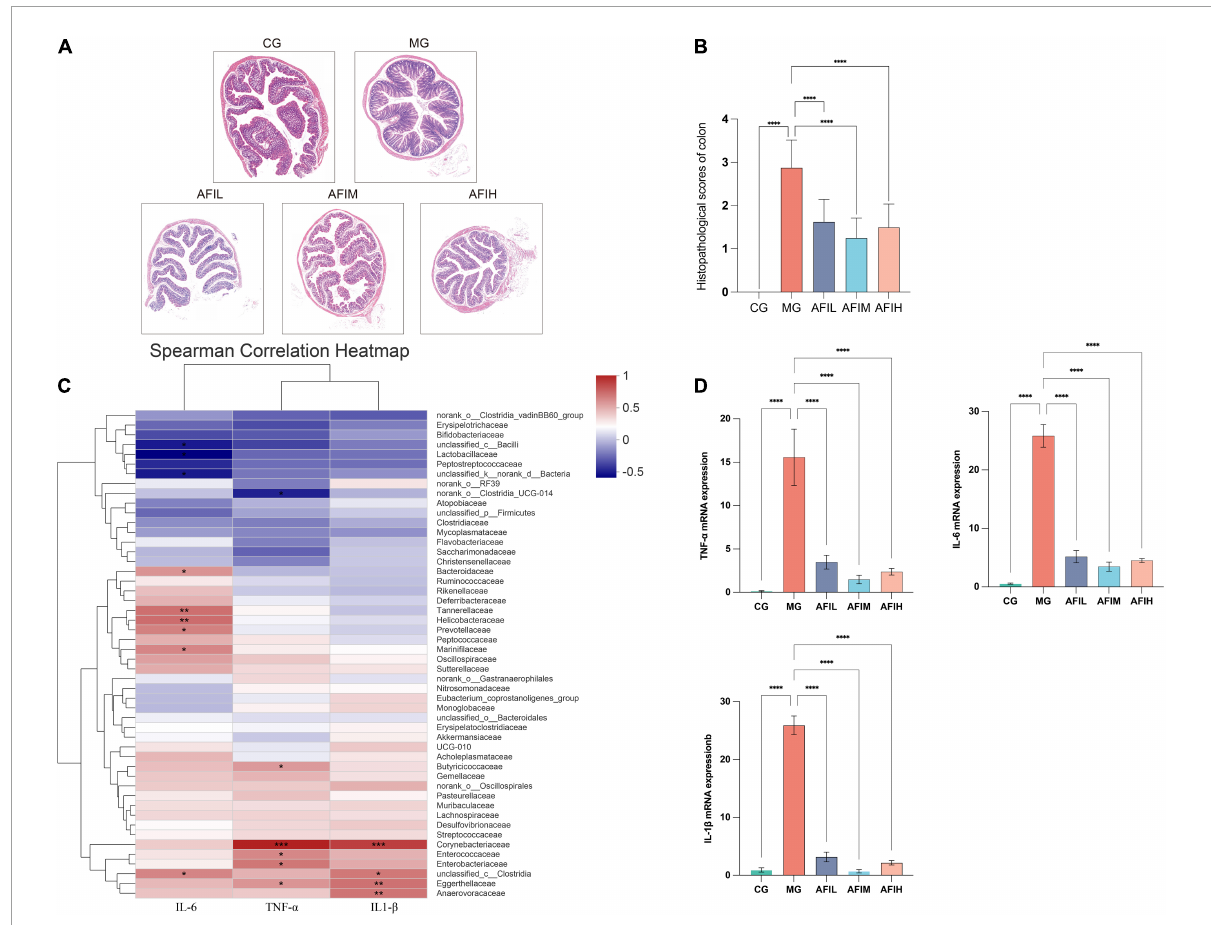
FIGURE3 Histopathological, Intestinal inflammatory factors and Spearman correlation heatmap in all mice. (A) The colons of each group were processed for histological evaluation (H&E staining, 50 × ). (B) Histopathological scores of each group were evaluated. Data are presented as means ± SD ( n = 8). ∗∗∗ p < 0.001, compared with the control group; * p < 0.05 and ** p < 0.01, compared with the MG group. (C) Correlation heatmap of IL-6, TNF-a, IL-1 and the microbiota. The X and Y axes are the environmental factors and families, respectively. R is shown in different colors. The right side of the legend is the color range of the different R values. The value of P < 0.05 is marked with “ ∗ ”. The value of P < 0.01 is marked with “ ∗∗ ”. The value of P < 0.005 is marked with “ ∗∗∗ ”. The value of P < 0.001 is marked with ∗∗∗∗ . (D) IL-6, TNF- α , and IL1- β